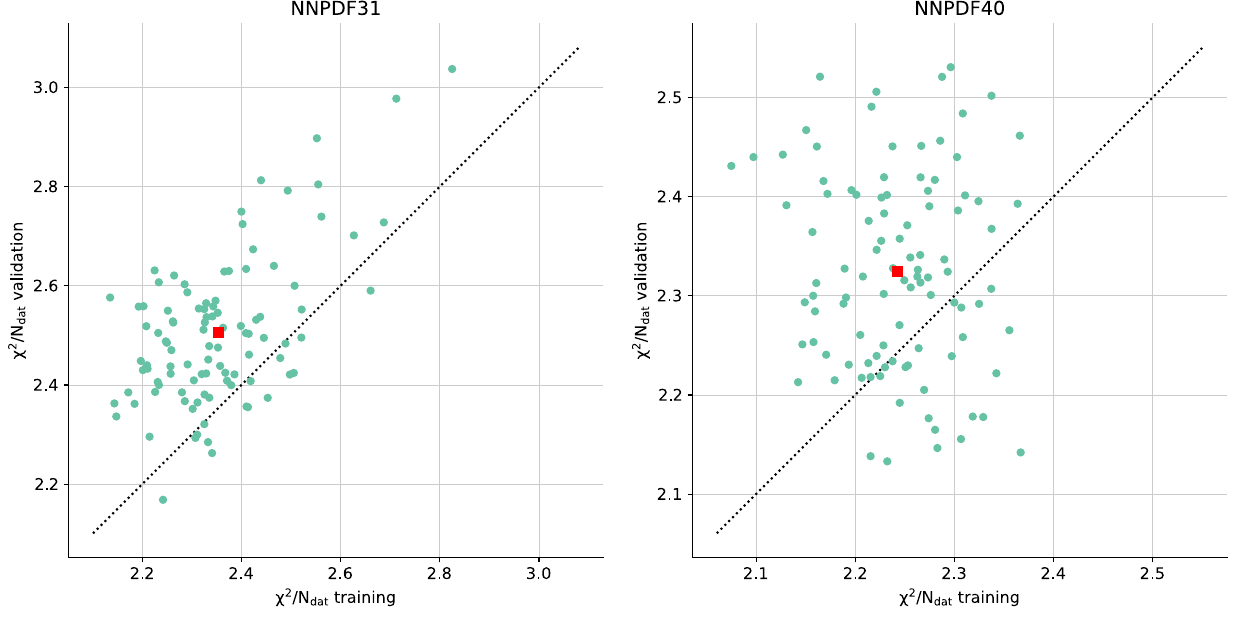
Fig. 13 Comparison of the values of the training and validation χ 2 for each replica between the NNPDF3.1 and NNPDF4.0 methodologies, when fitting a common dataset. The red square indicates the mean value over the